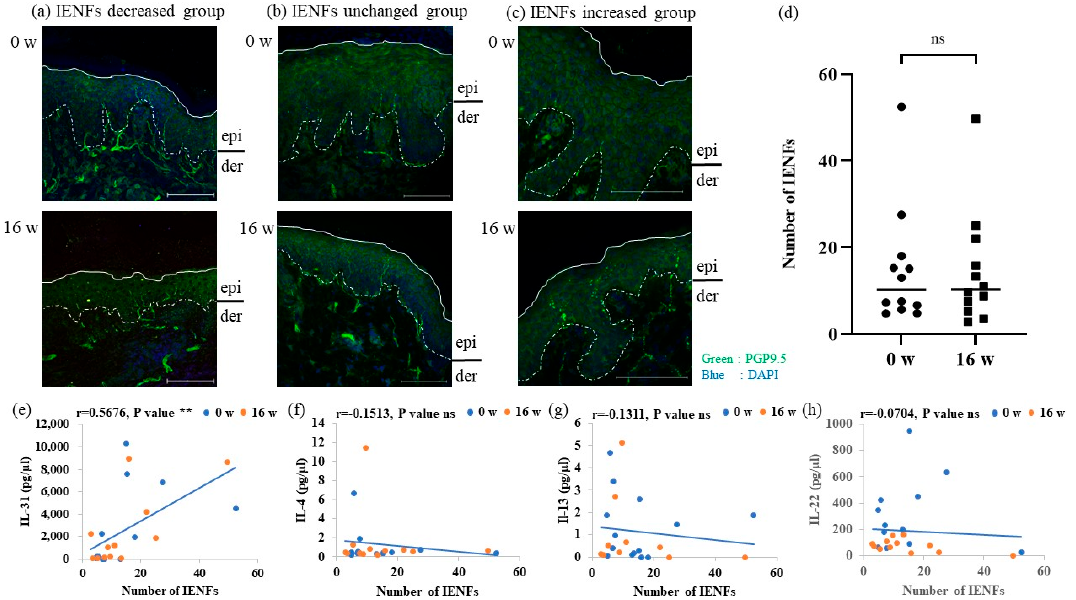
Figure 5. Distribution of IENFs in atopic dermatitis patients before and after the dupilumab treatment. ( a – c ) Distribution of IENFs before and after the dupilumab treatment. 0 weeks ( upper ). 16 weeks ( lower ). The white line in each panel indicates the surface of the epidermis and the white dotted line indicates the border between the epidermis and dermis (basement membrane). Scale bars = 100 µ m. epi, epidermis; der, dermis. ( a ) The group with decreased IENFs. ( b ) The group with no changes in IENFs. ( c ) The group with increased IENFs. ( d ) All IENFs. ( e – h ) Correlation analyses of serum levels of ( e ) IL-31, ( f ) IL-4, ( g ) IL-13, and ( h ) IL-22. Data are shown as the mean ± standard error of the mean (n = 12 per group). Coefficients (r) were assessed by Spearman’s rank correlation test. ** p < 0.01. Statistical analyses were performed with the unpaired t-test. IENFs, intraepidermal nerve fibers; ns, not